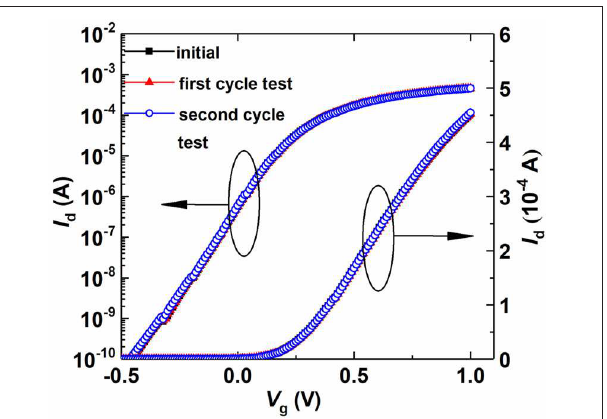
FIGURE 2 | Schematic diagram of the PBTI test setup. The PBTI test contains a 500s stress phase and a 500s recovery phase. During the stress phase, PBTI stress is set to be 2.7 and 5.0 MV/cm for Al 2 O 3 for a duration of 500s.